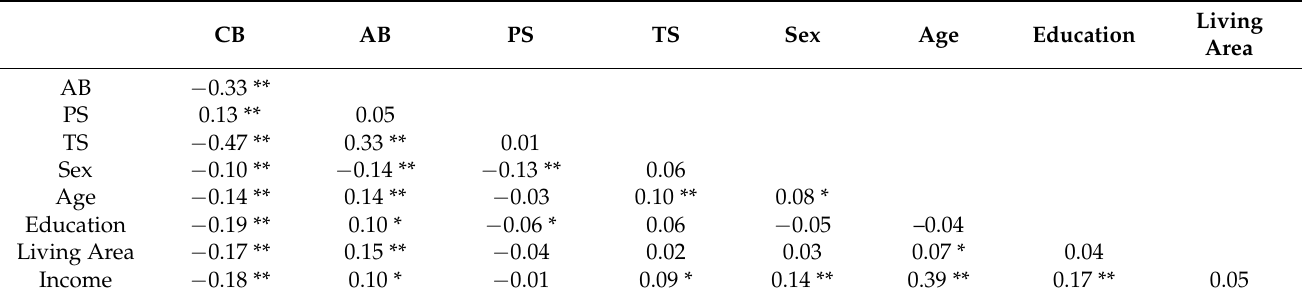
Table 2. Correlations between